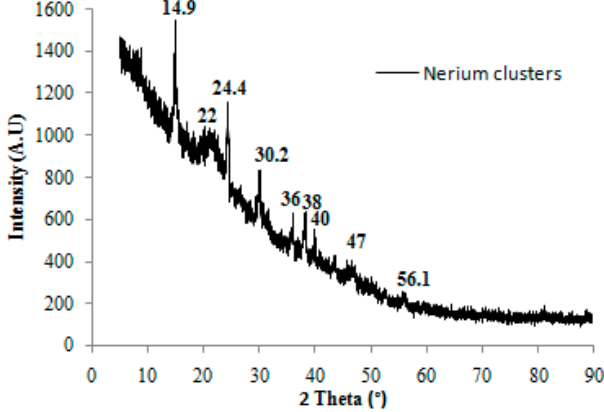
Figure 3. XRD patterns of Nerium oleander fruit.